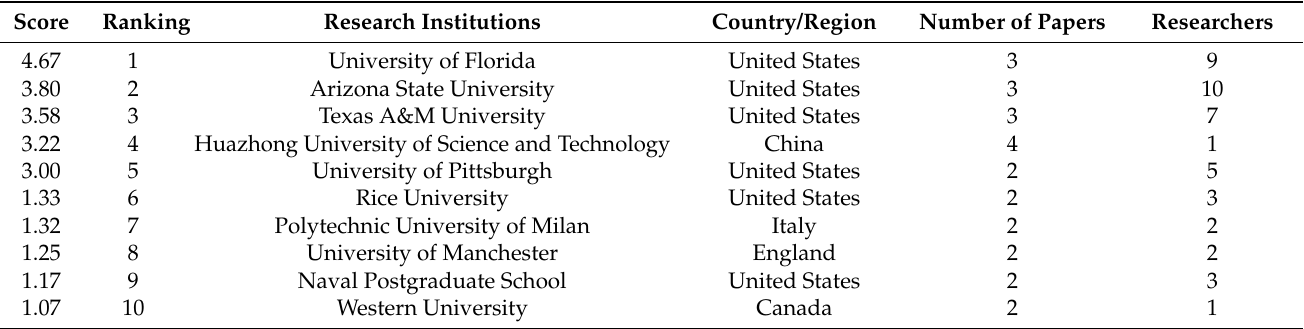
Table 4. Top 10 research institutions publishing papers on